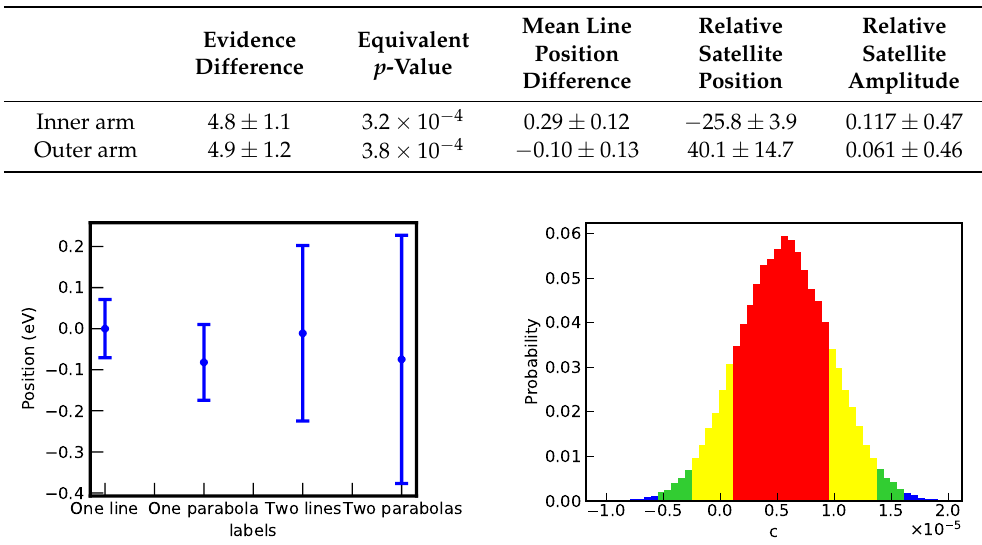
Figure 4. ( Left ): main spectral line position for different models. ( Right ): Probability distribution for the quadratic term of the spectral component for the Li-like